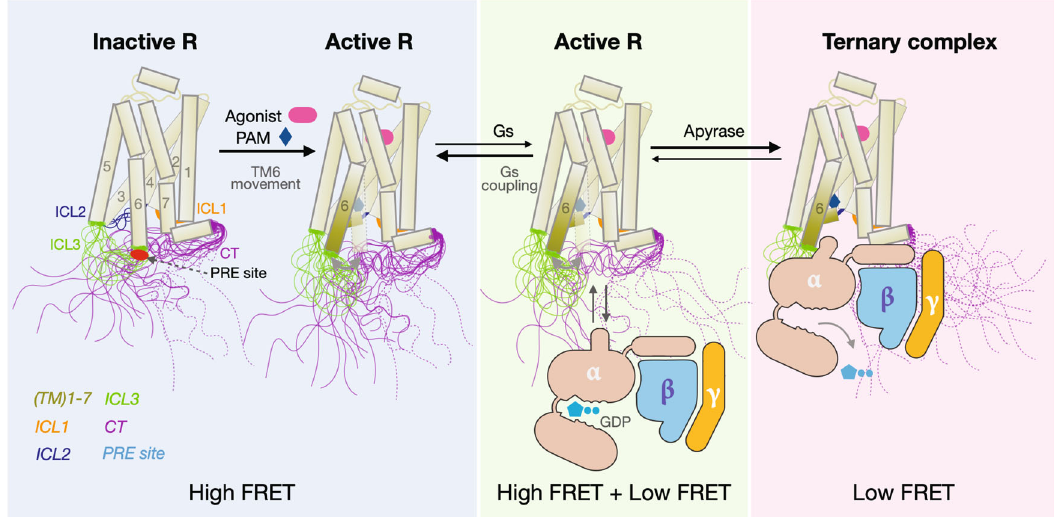
Fig. 8 | Model illustrating the role of the β 2AR-[CT] dynamics in G-protein activation. In the inactive state, the disordered CT of the β 2 AR adopts multiple conformations and directly interacts with intracellular loops of the TM core. The solidlinesrepresentconformationsoftheCTdirectlyinteractingwiththeTMcore, while the dashed lines represent conformations ofthe CT thathave spontaneously dissociated from the TM core. The agonist and positive allosteric modulator pro- mote the outward movement of TM6 and the transition of ICL2 to a helix. These